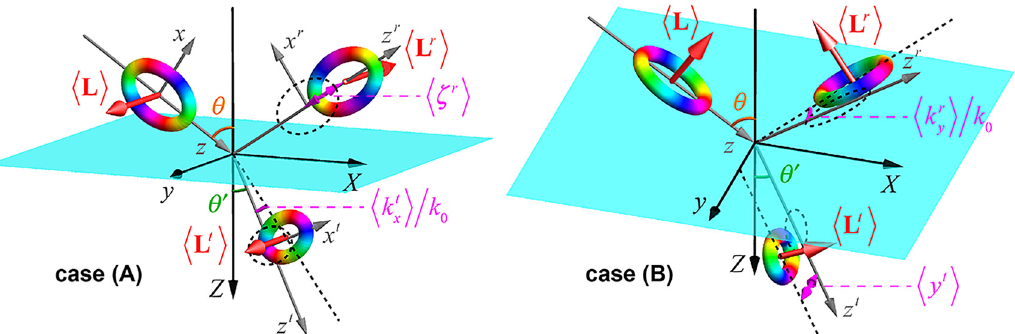
Figure 2: Schematics of the reflection and refraction of an STVP at a planar interface. The incident, reflected, and transmitted pulses, together with their accompanying coordinate frames and intrinsic OAM are shown for the two geometries (A) and (B) (see details in the text). ⟩ are shown for the reflected and transmitted pulses in (a), whereas the transverse The longitudinal shift (time delay) ⟨ 𝜁 ⟩ and angular shift ⟨ k x ⟩ are shown for the transmitted and reflected pulses in shift ⟨ y ⟩ and angular shift ⟨ k y